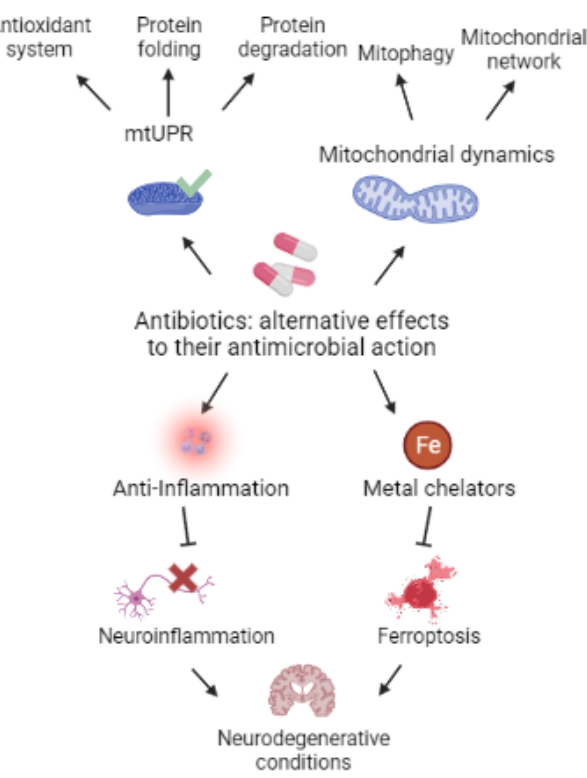
Figure 2. Alternative effects of antibiotics apart from their anti-microbial Figure 3. This is a wide figure.